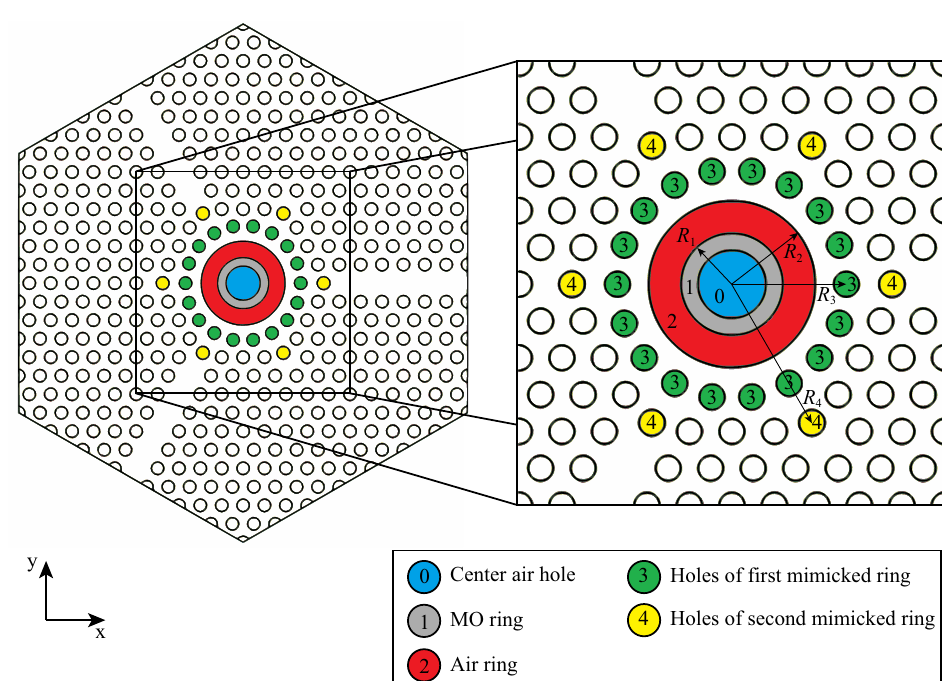
Figure A1. Top view of the circulator (resonator geometry is highlighted in the